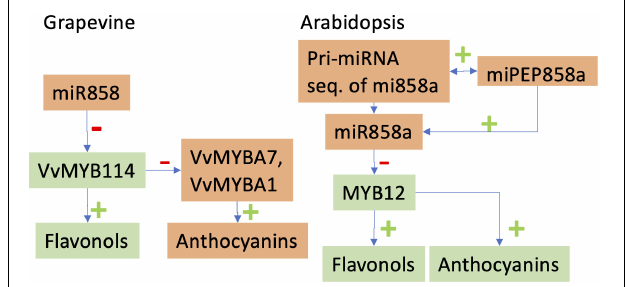
FIGURE 2 | Comparative effects of miR858 in Vitis vinifera (Tirumalai et al., 2019) and miR858a in Arabidopsis thaliana (Sharma et al., 2020). Levels of elements with different colors vary in opposite directions. In the grapevine, the micro RNA miR858 targets a repressor of the anthocyanin pathway, VvMYB114. In Arabidopsis, the primary miRNA of miR858a encodes for the small peptide miPEP858a. Growing Arabidopsis seedlings in presence of miPEP858a demonstrated that this micropeptide enhances the expression of